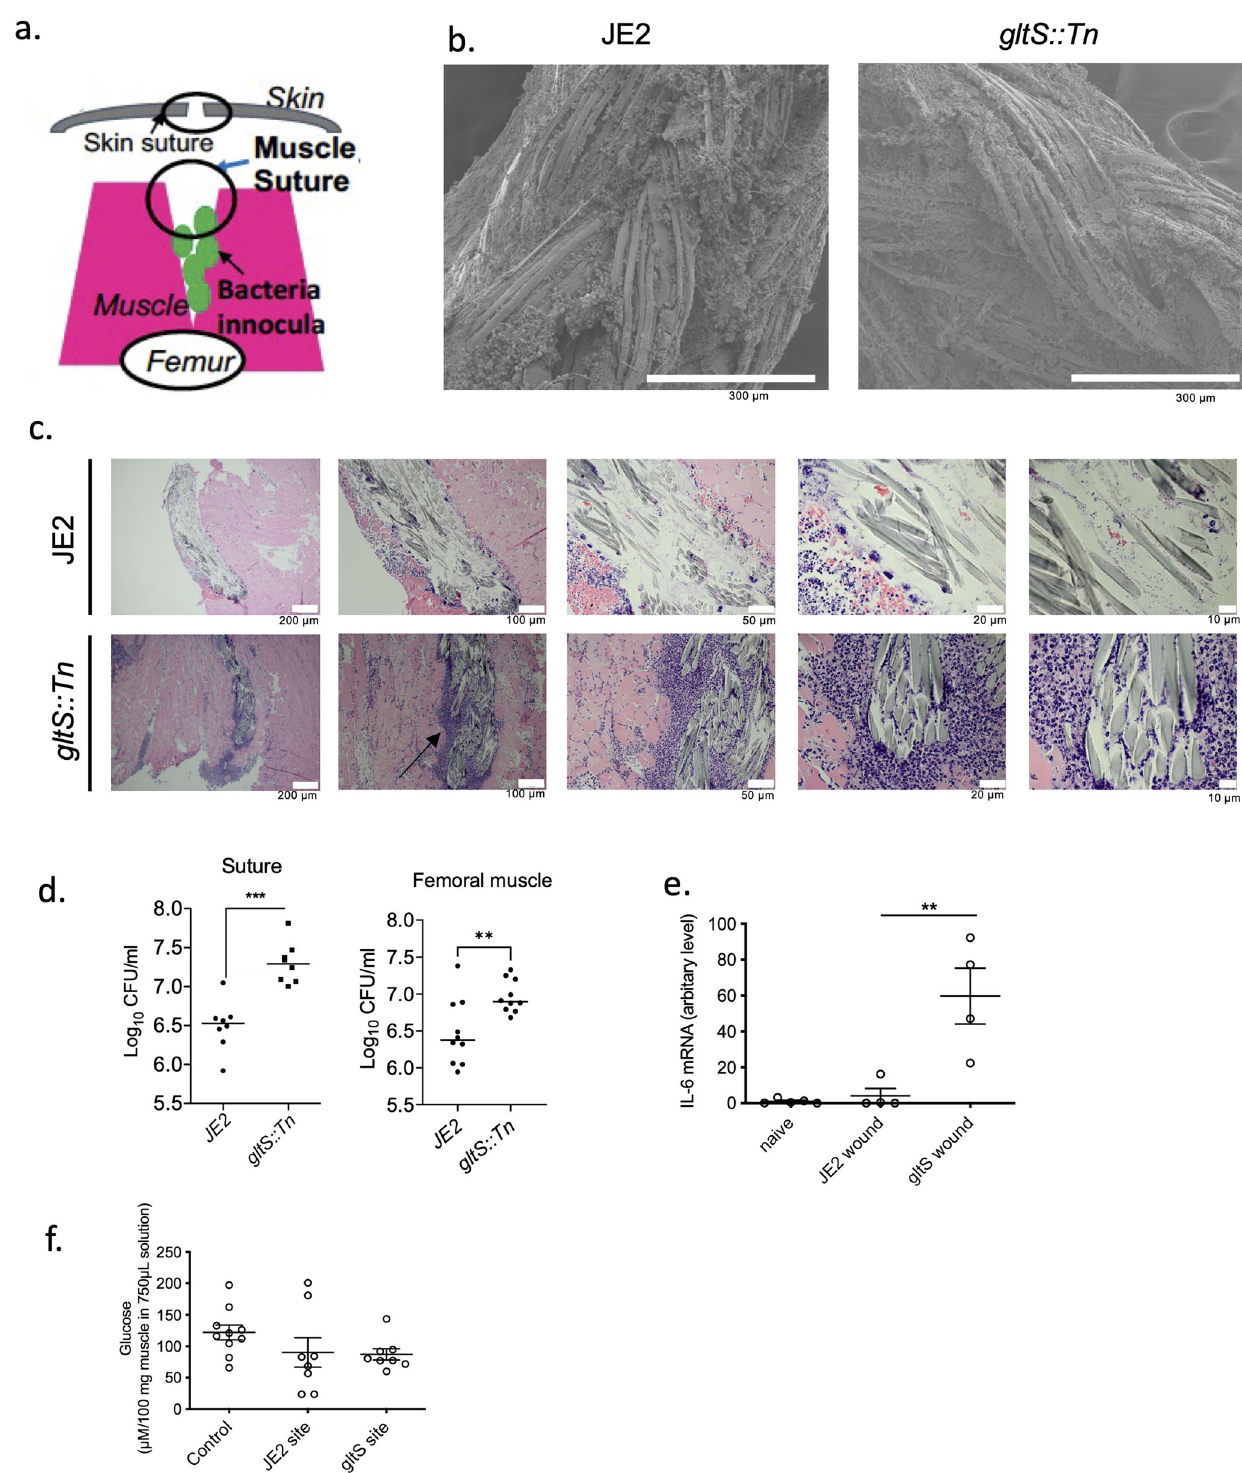
Fig. 2 Bio fi lm formation of gltS transposon mutant in vivo. a Scheme of a murine wound infection model. b SEM image of muscle sutures. Representative images from two independent experiments. Scale bar (white) in each image. c Hematoxylin and eosin (H&E) staining of the surgical infection site. Scale bar (white) in each image. A black arrow indicates extensive leukocyte in fi ltration. d Sutures were sonicated in the same volume of PBS for each strain, and the CFUs were counted. Muscle sections of the same weight from each mouse were homogenized, and the CFUs in the homogenized suspensions were quanti fi ed. Data are shown as mean ± SD of 8 mice for suture and 10 mice for muscle sample. e IL-6 mRNA levels in the wound tissues at 48 h after infection with JE2 or gltS::Tn were examined using RT-qPCR. Data are shown as mean ± SD of 4 replicates. One way ANOVA with post hoc Bonferroni analysis was done. ** p < 0.01. f Glucose levels at the wound were measured. Data are shown as mean ± SD of 6 replicates. One way ANOVA with post hoc Bonferroni analysis was done. No statistical signi fi cance was